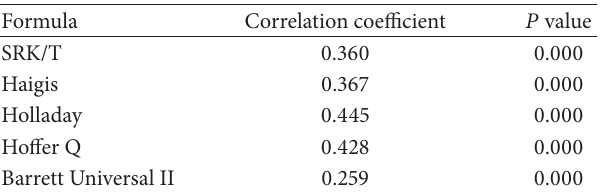
Table 6: Association between absolute predicted error and axial length.